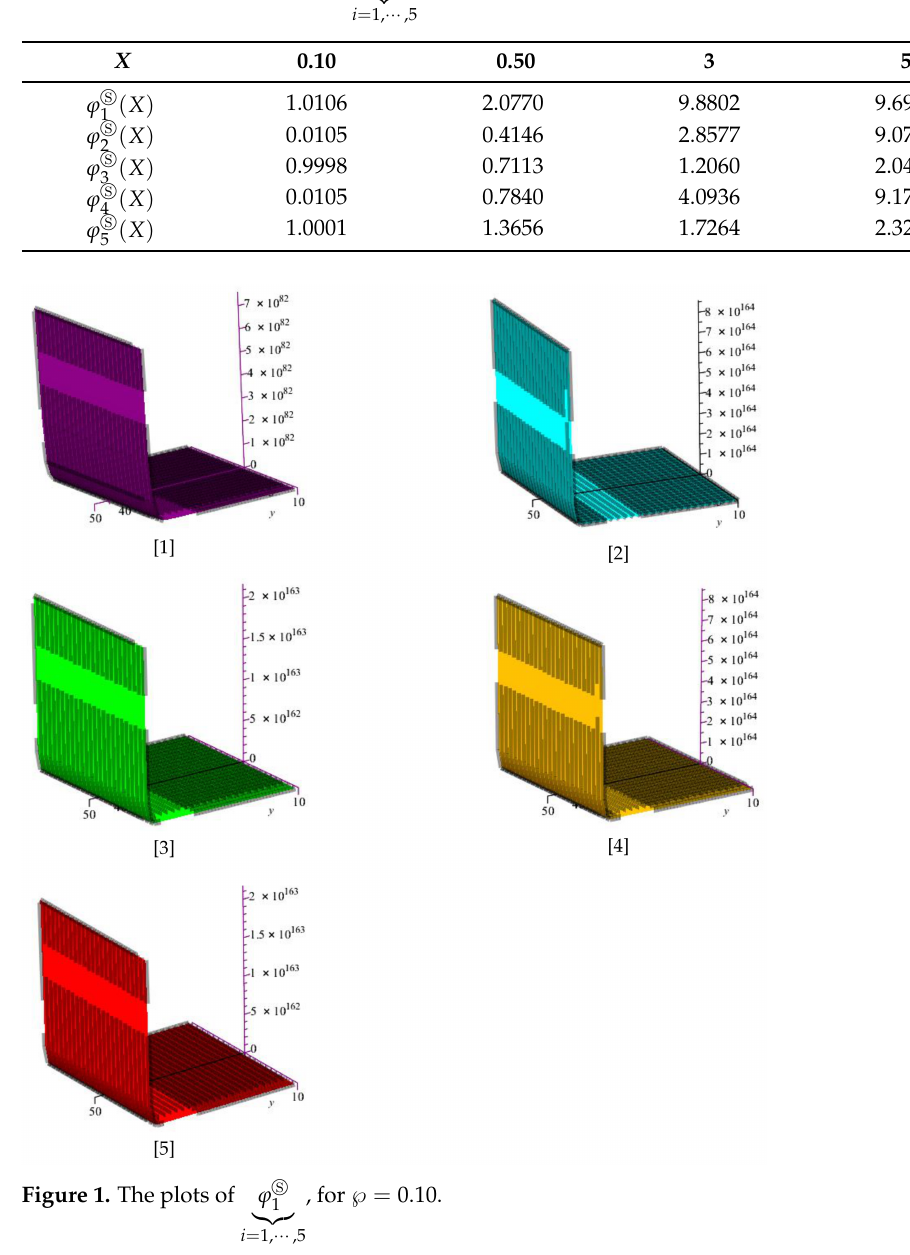
Figure 1. The plots of ϕ